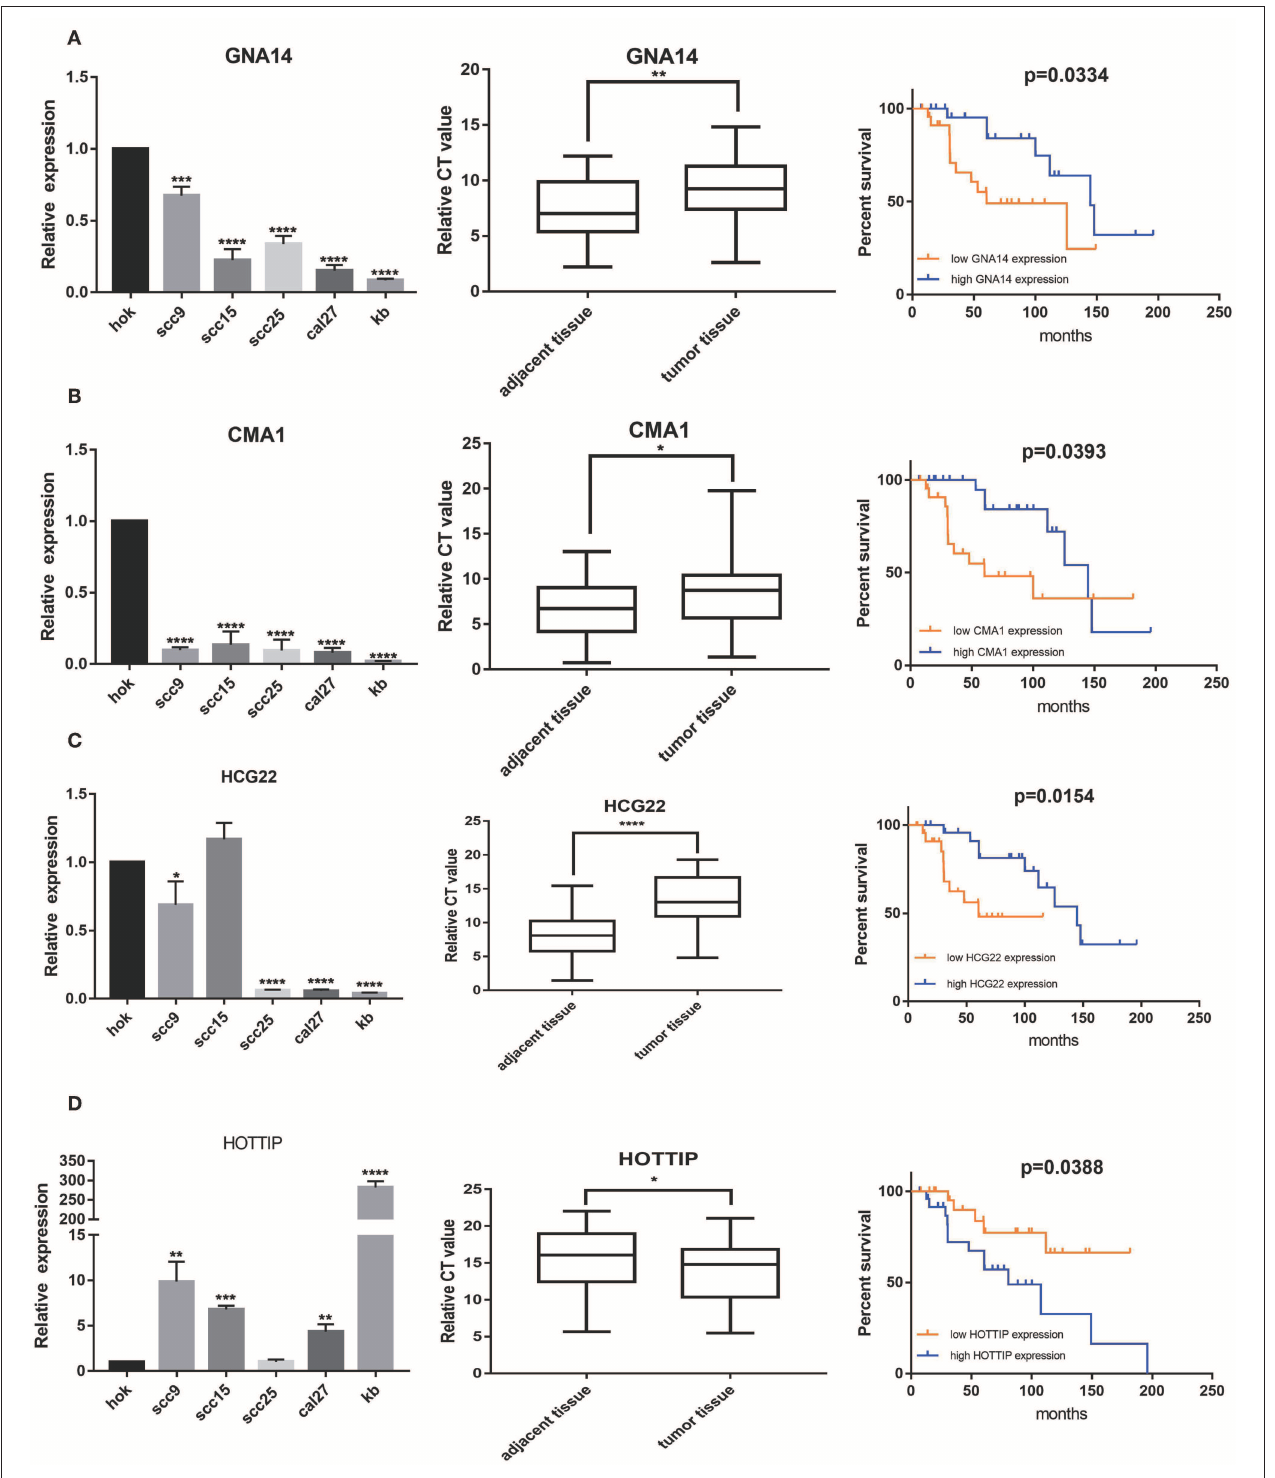
FIGURE 7 | The expression levels of 2 mRNAs, GNA14 (A) and CMA1 (B) , and 2 lncRNAs HCG22 (C) , and HOTTIP (D) in 5 OSCC cell lines and 49 pairs adjacent tissues and tumor tissues. HOK is used as control. Then, Kaplan–Meier analysis along with logrank p was used to compare the survival of the low expression group and the high expression group. However, mRNA levels of DKK1 (E) and HOXC6 (F) showed no difference in OSCC tissues. * p < 0.05; ** p < 0.01; *** p < 0.001; **** p < 0.0001.